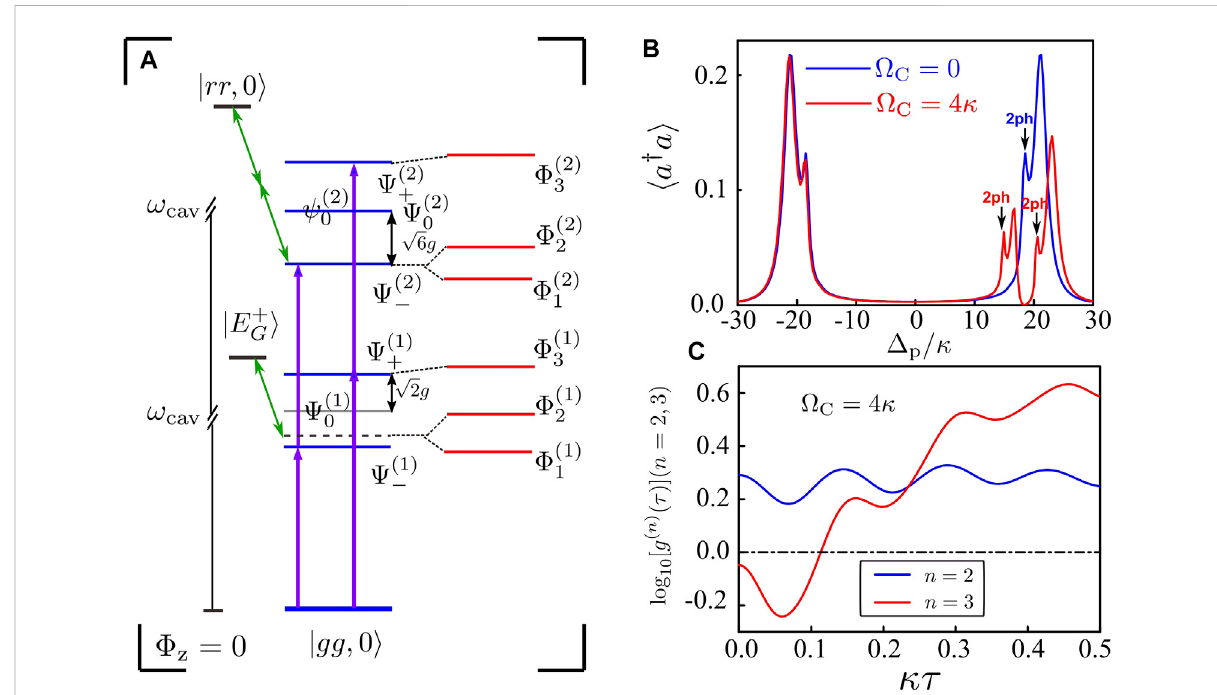
FIGURE 2 (Coloronline) (A) Schematicenergy-levelstructurediagramexplainingtheenergysplittinginducedby Ω C inthecaseof Φ z =0. (B) Meanphoton number 〈 a † a 〉 as a function of normalized detuning Δ p / κ for the Ω C = 0 (blue solid curve) and Ω C = 4 κ (pink solid curve). (C) Time-dependent fi eld correlation functions log 10 [ g (2) ( τ )] and log 10 [ g (3) ( τ )] versus the normalized delay time κτ with Δ p = 21.3 κ . The strength of the probe fi eld is Ω p = 0.8 κ in panel (B) and Ω p = 1.5 κ in panel (C) . Other system parameters are chosen as g 0 = 15 κ , γ er = 1 κ , and γ ge = γ er